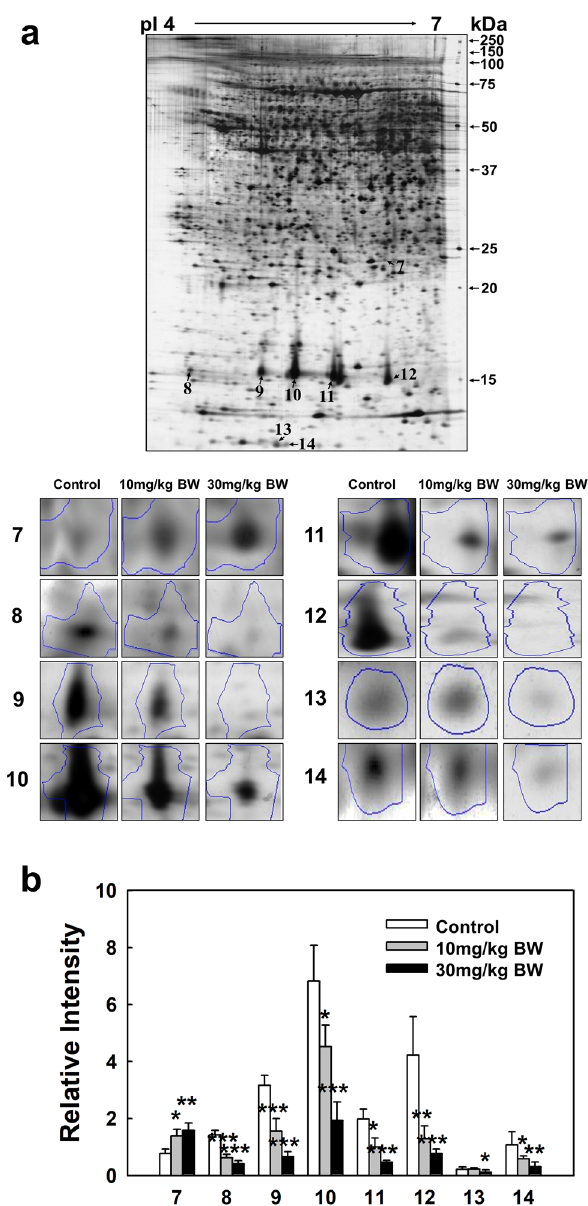
Figure 4. 2-DE analysis of kidney tissue proteins obtained using 4–7 pI range strips. ( a ) Gel pattern of tissue proteins obtained using 4–7 pI strips. Protein spot images were analyzed using the Progenesis Samespot software program (Nonlinear Dynamics, Newcastle upon Tyne, UK). ( b ) Spot volumes were normalized by comparison to the total spot volume. The quantity of each spot is presented as the relative intensity. The images represent the mean ± SD of five separate experiments. *, **, and *** indicate p -values of 0.05, 0.01, and 0.001, respectively, compared to the